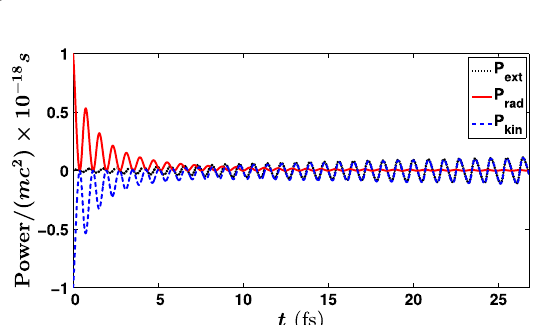
ð t Þ and P LAD ð t Þ for the uniform rad rad